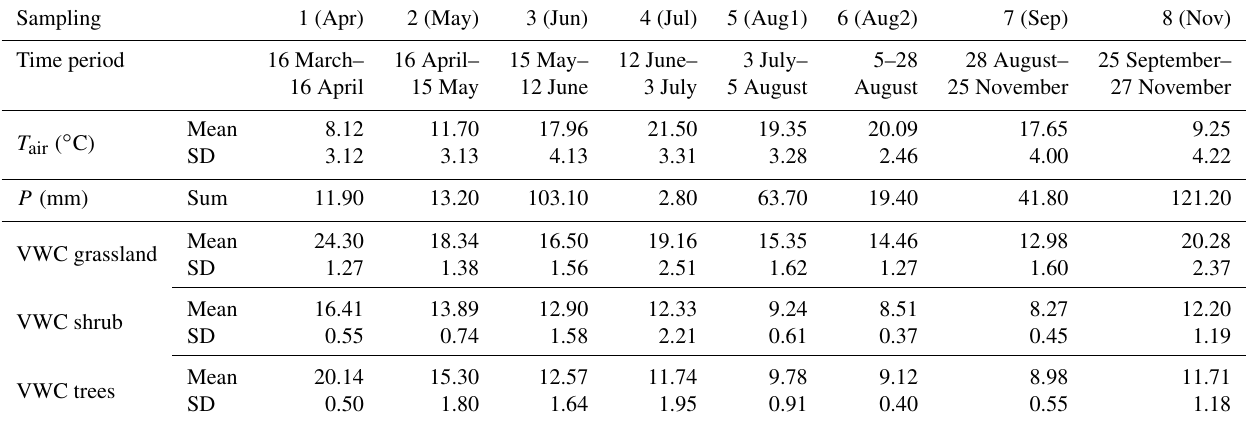
Table 3. Climate parameters (DWD, 2020a) and VWC under the different vegetation units in the month before or weeks between the individual soil sampling campaigns.